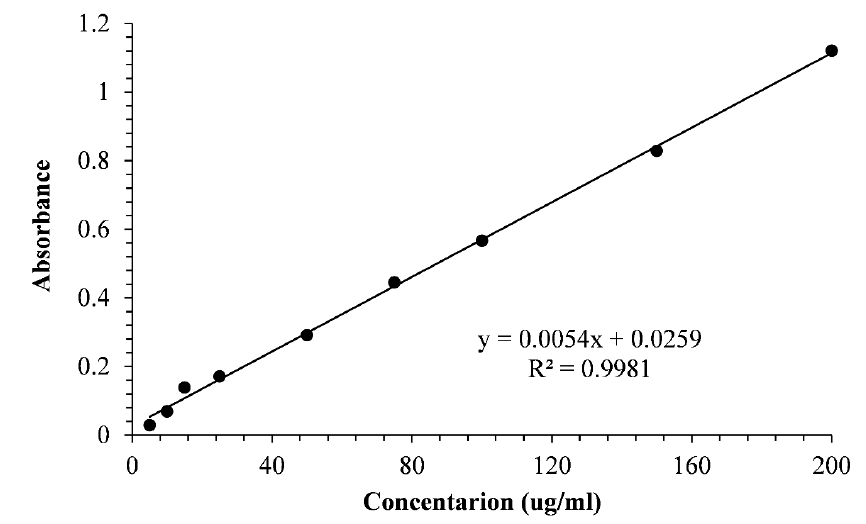
FIGURE 5 - Calibration curve for the reaction mixture containing ninhydrin acetone